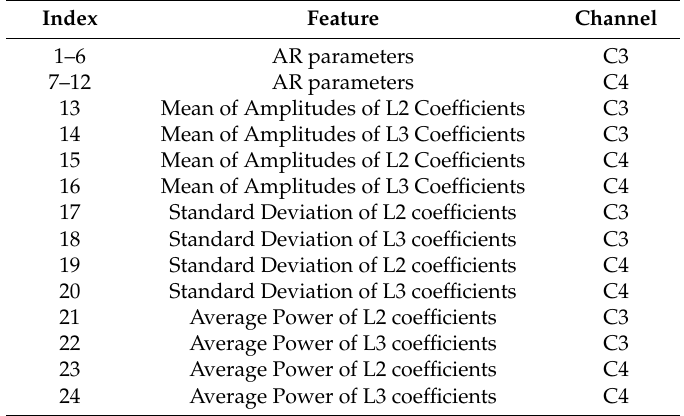
Table 2. Feature vector structure for a single time window. AR: